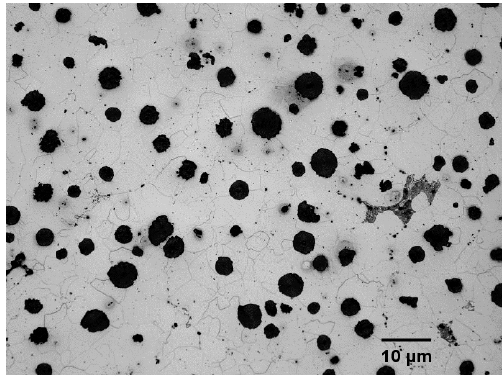
Figure 6. Microstructure of nodular cast iron without heat treatment.